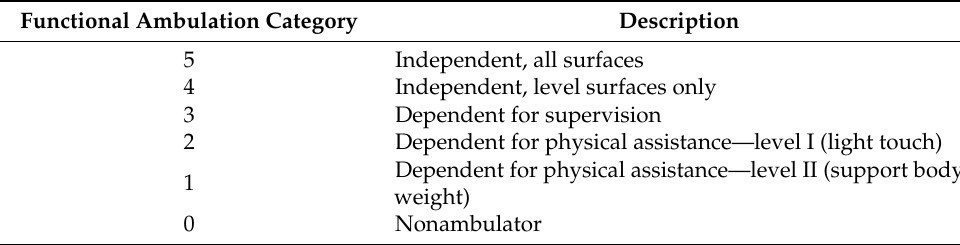
Table 1. Functional ambulation classification